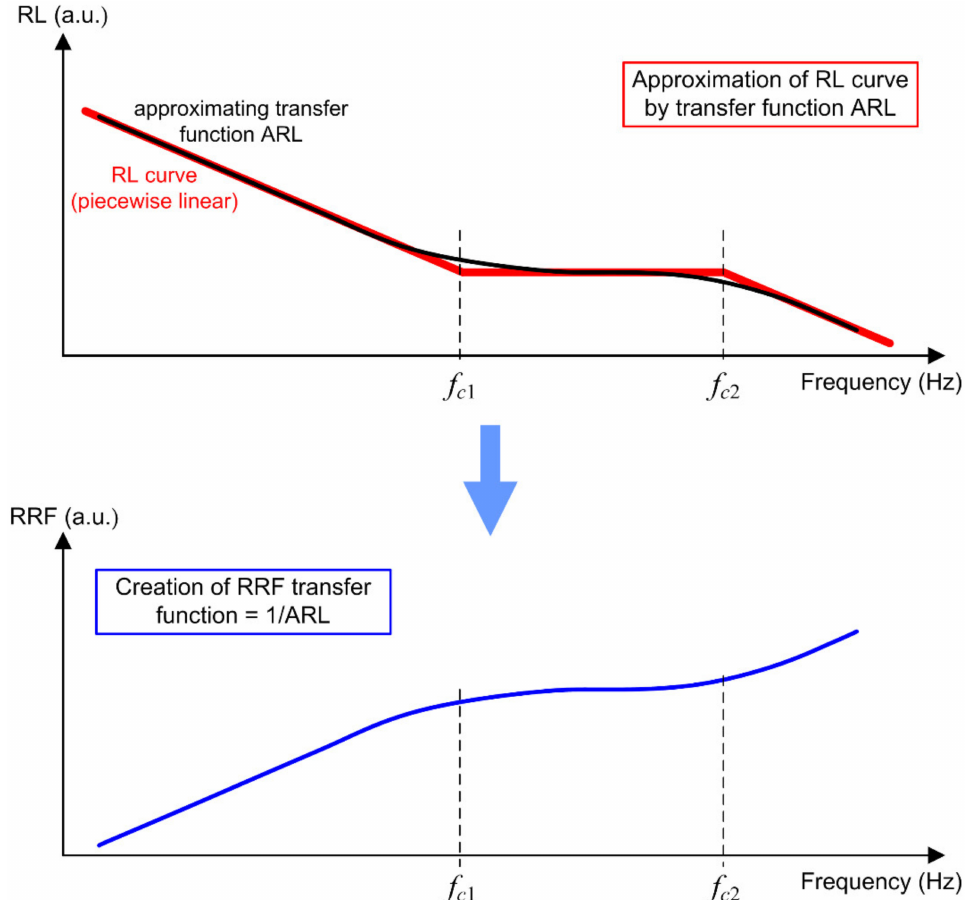
Figure 5. Graphical derivation of RRF transfer function from the RL curve approximation (indicated as ARL): a piecewise linear RL curve with first-order slope changing at corner frequencies f c 1 and f c 2 is